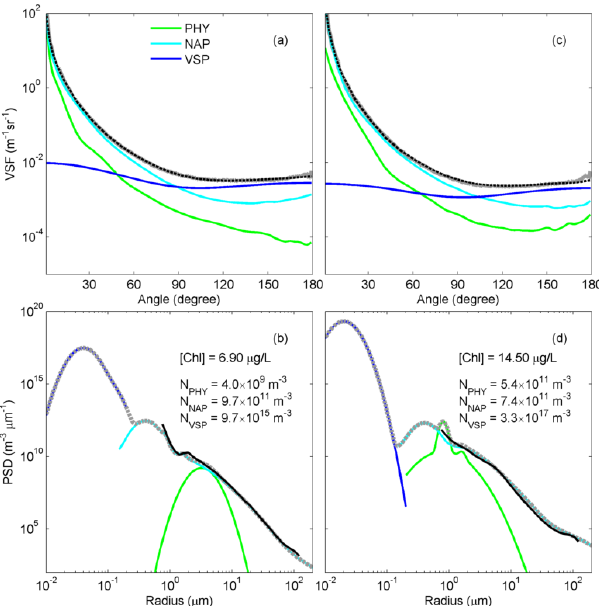
Fig. 4. Inversion results for station CB3 (circled in Fig. 1) on 20 Oc- tober 2009, ( a and b ), one day after an extended rain event and on 22 October ( c and d ) when an algal bloom was observed. ( a and c ) The measured VSFs were partitioned into contributions by phyto- plankton particles (PHY), non-algal particles (NAP) and very small particles (VSP). The solid gray lines are the measured VSFs and the dashed black lines are the sum of the groups’ VSFs representing the best fit obtained during the inversion. ( b and d ) The corresponding particle size distributions (PSD) for the three particle groups (cut off at the filter pore size of ∼ 0.2µm). The solid black lines are the PSDs derived from the LISST measurements and the dashed gray lines are the sum of the PSDs for each group. Also shown are the HPLC chlorophyll concentration ([Chl] on the figure) and the parti- cle concentration estimated for each